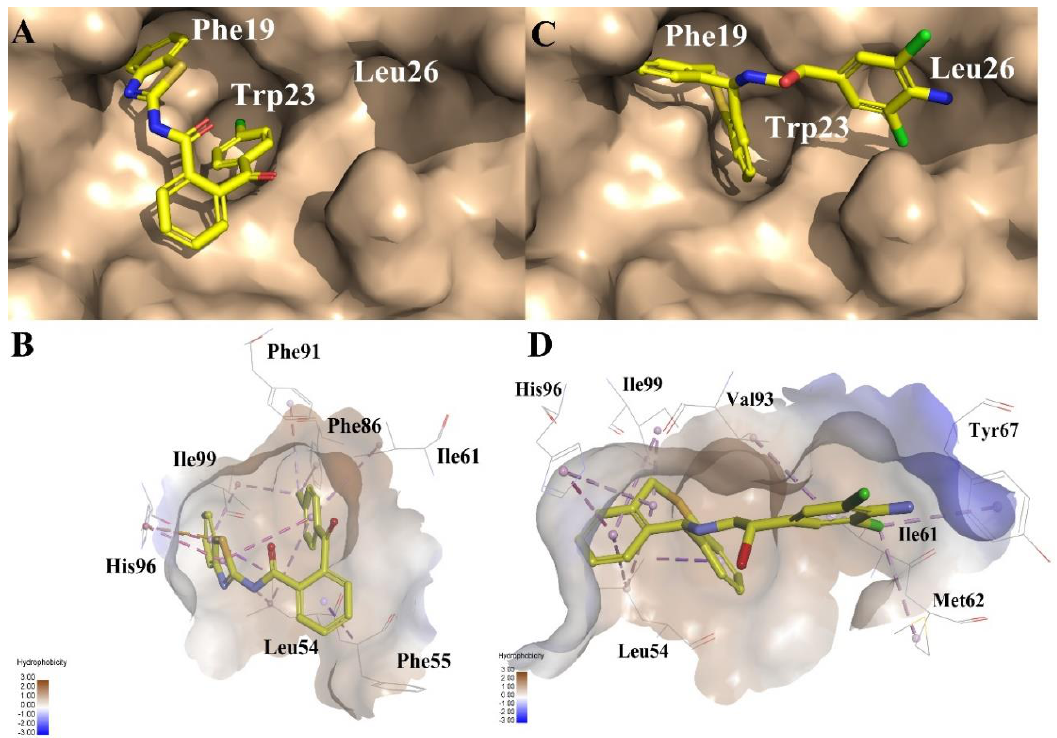
Figure 8. Predicted binding modes of ( A ) and ( B ) compound 3 , ( C ) and ( D ) compound 4 to MDM2. The protein displays as α helix with a gray surface. The HB donor and acceptor are displayed as purple and green. All compounds are shown with only backbone atoms.